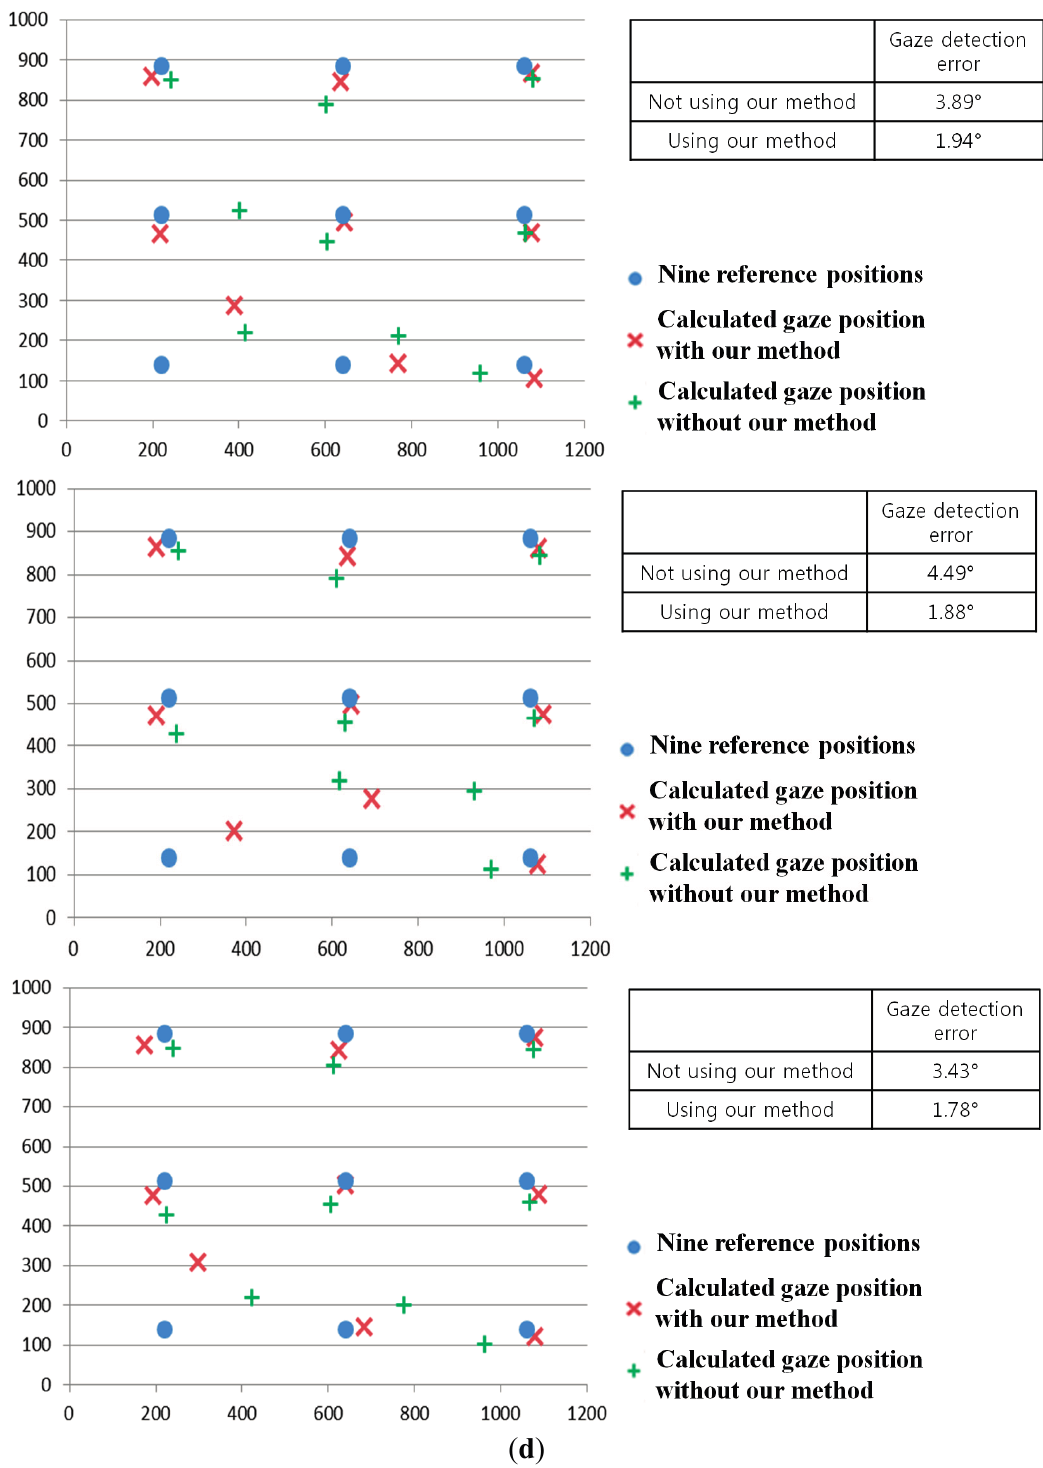
Figure 32. Comparisons of gaze detection errors with five people having various head rotations and translations without and with our method of Section 2.5 in the presence of the halogen lamp at various positions (like Figure 25). ( a ) above monitor display; ( b ) right of monitor display; ( c ) below monitor display; ( d ) left of monitor display (In the Figure 29a–d, the 1st–6th Figures represent the cases of head rotations in X, Y, Z axes, and head translations in X, Y, Z axes of Figure 31,